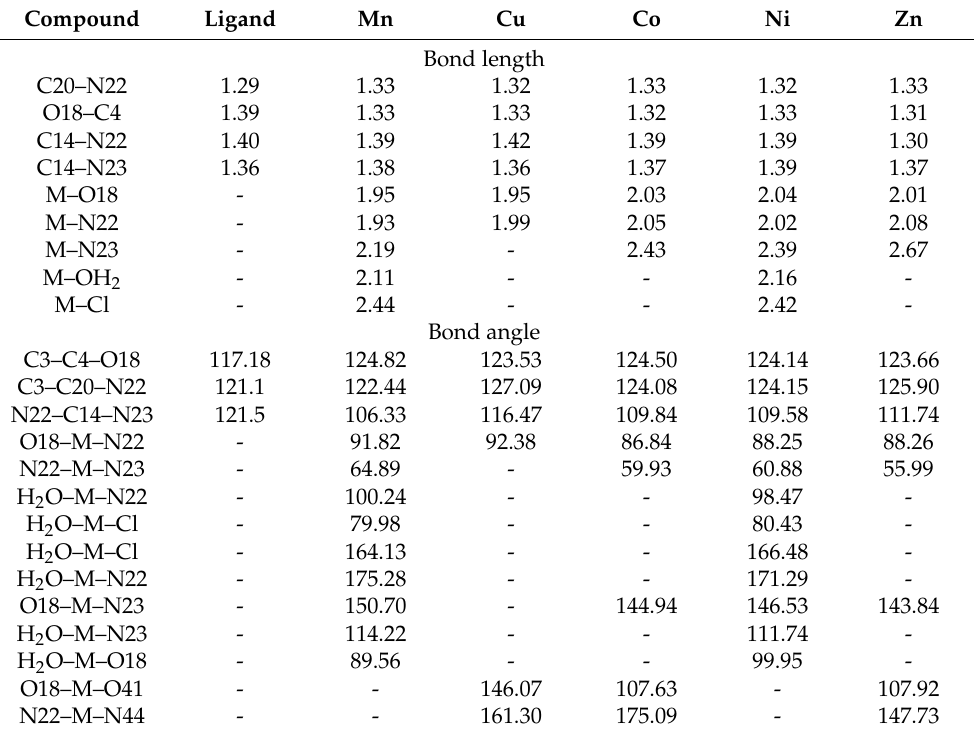
Table 1. Selected geometric bond lengths and bond angles of the optimized ligand and its complexes using B3LYP/LAND.